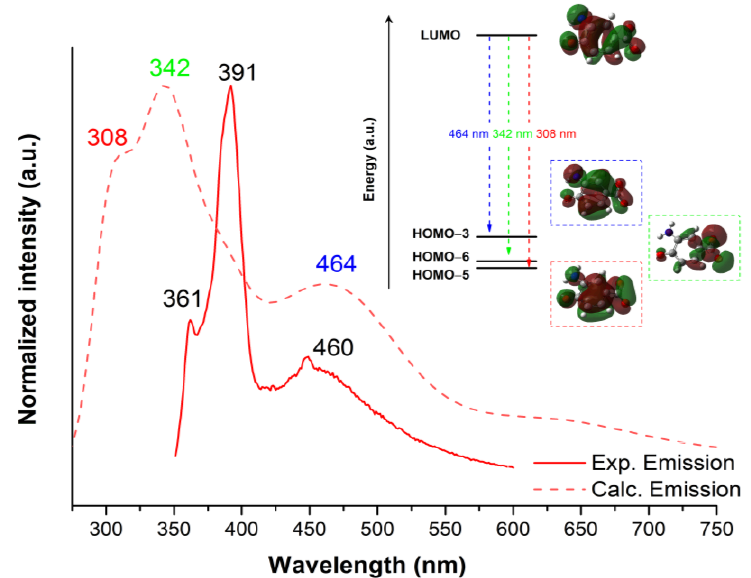
Figure 7. Room temperature time-dependent density-functional theory (TD-DFT) computed (dashed lines) and experimental (solid lines) photoluminescence under λ ex = 330 nm polycrystalline homometallic Zn II complex. The insets show the most representative molecular orbitals involved in the electronic transitions.